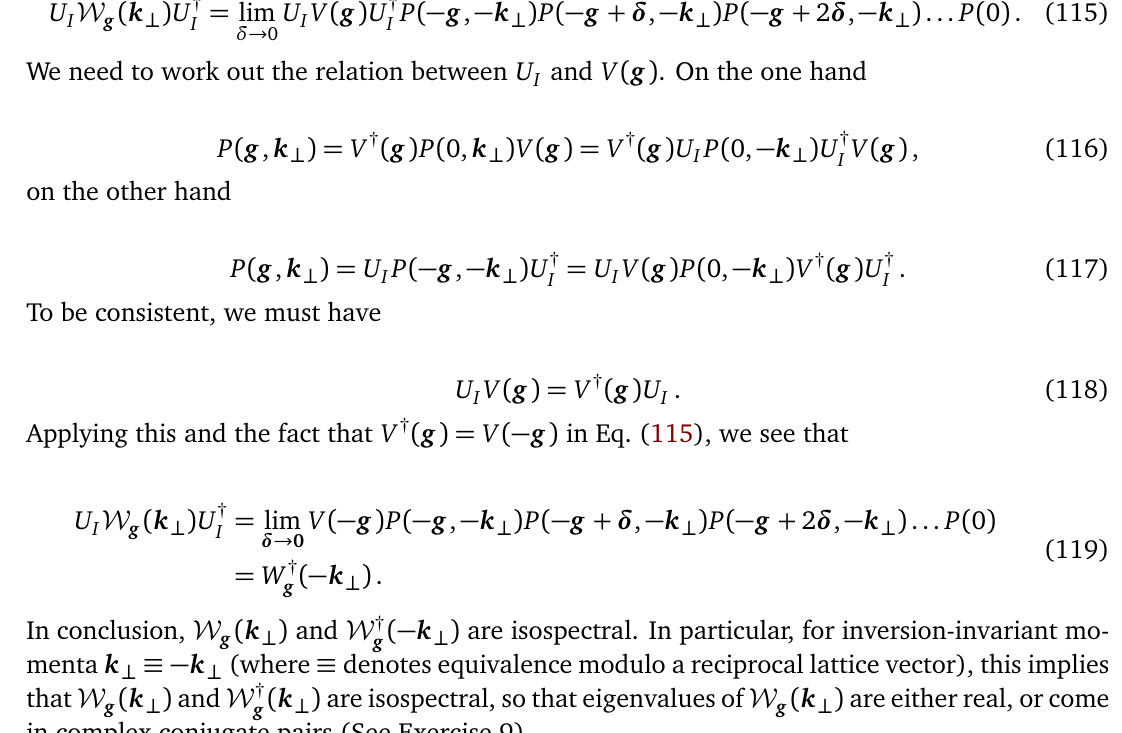
Figure 8: In black, the graphical discretization of the Wilson loop the derivation of the effect of inversion and time-reversal on it. In blue, the Wilson ( − k (cid:48) ) to which it is related by these † loop g W